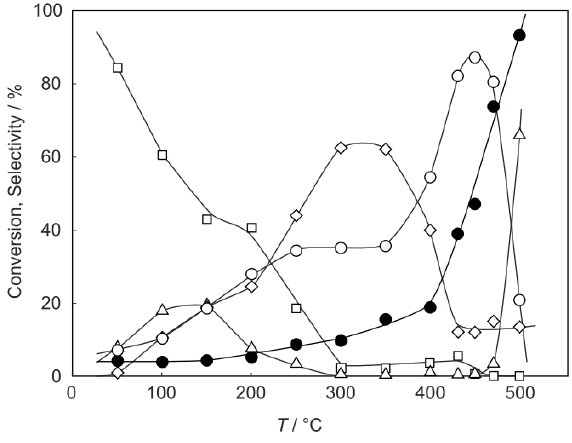
Figure 30. Effect of temperature on the reaction of benzenethiol with methyl acetate in the presence of [(Nb 1.0 mmol/h) and methyl acetate (795 μL/h, 10.0 mmol/h) was reacted. Other